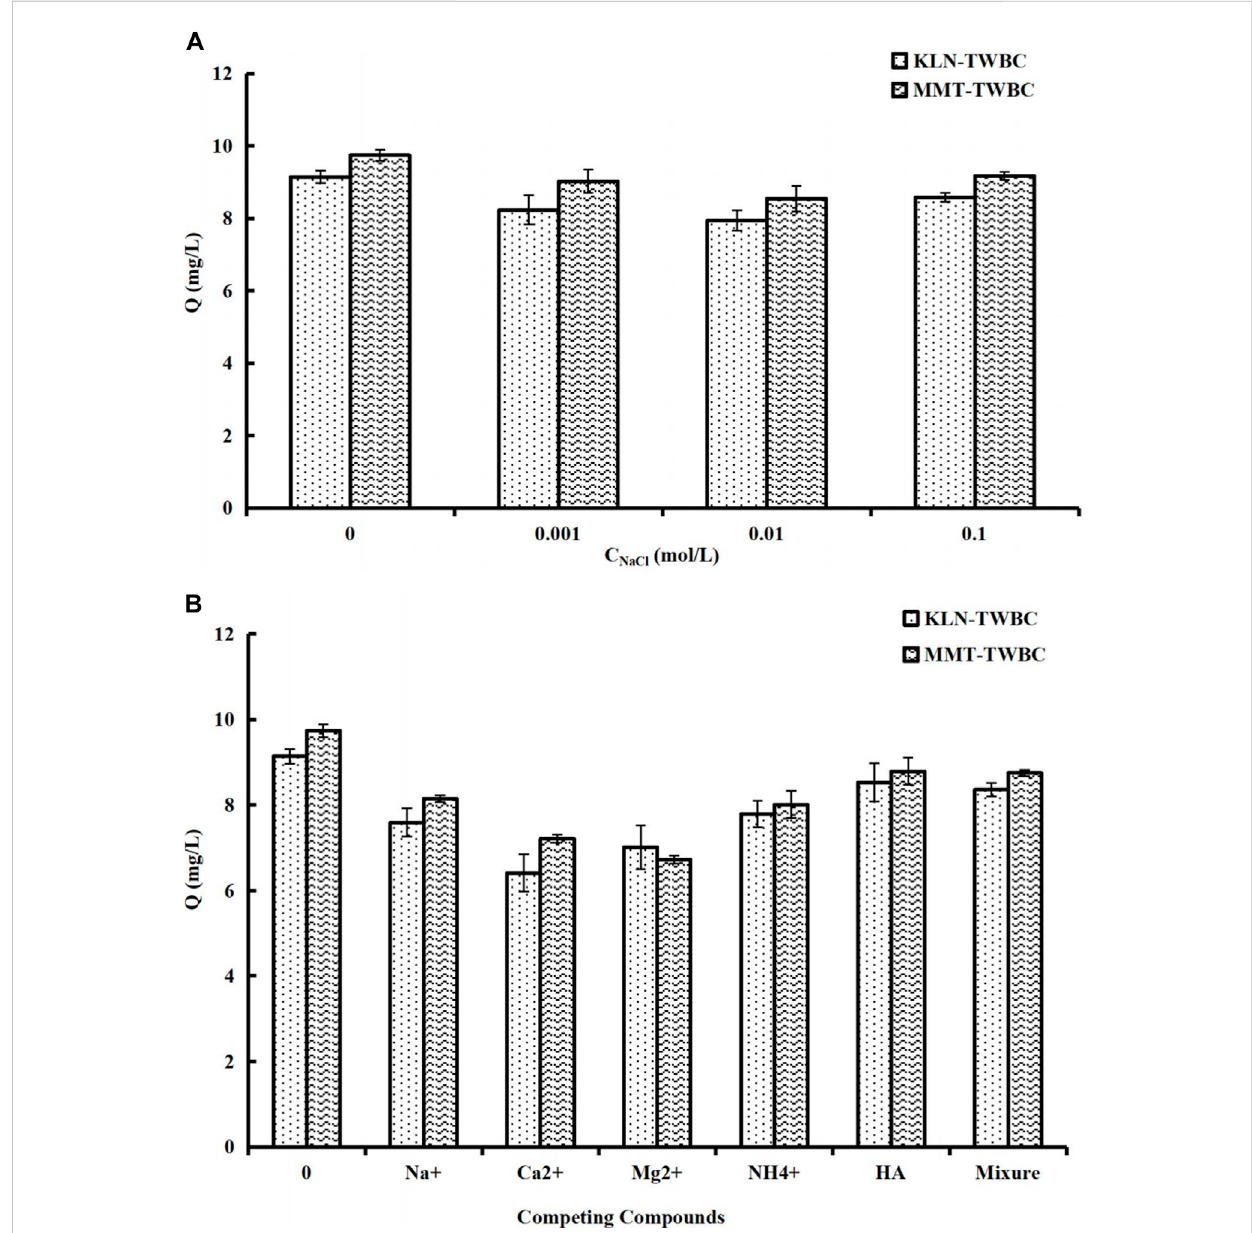
Effect of (A) ionic strength (IS) and (B) competing compounds on MB adsorption for KLN-TWBC and MMT-TWBC (Initial MB concentration of 20 mg/L, contact time 48 h, temperature 25 ° C ± 0.5 ° C, adsorbent dose 2 g/L, MB solution 25 mL, and pH 6.80 ± 0.10). KLN-TWBC, kaolinite modi fi ed tea waste